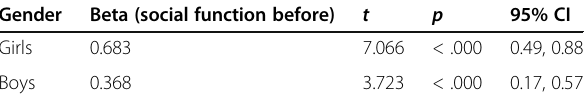
Table 3 Conditional effects of behaviour before orthodontic and surgical treatment on behaviour after treatment depend on